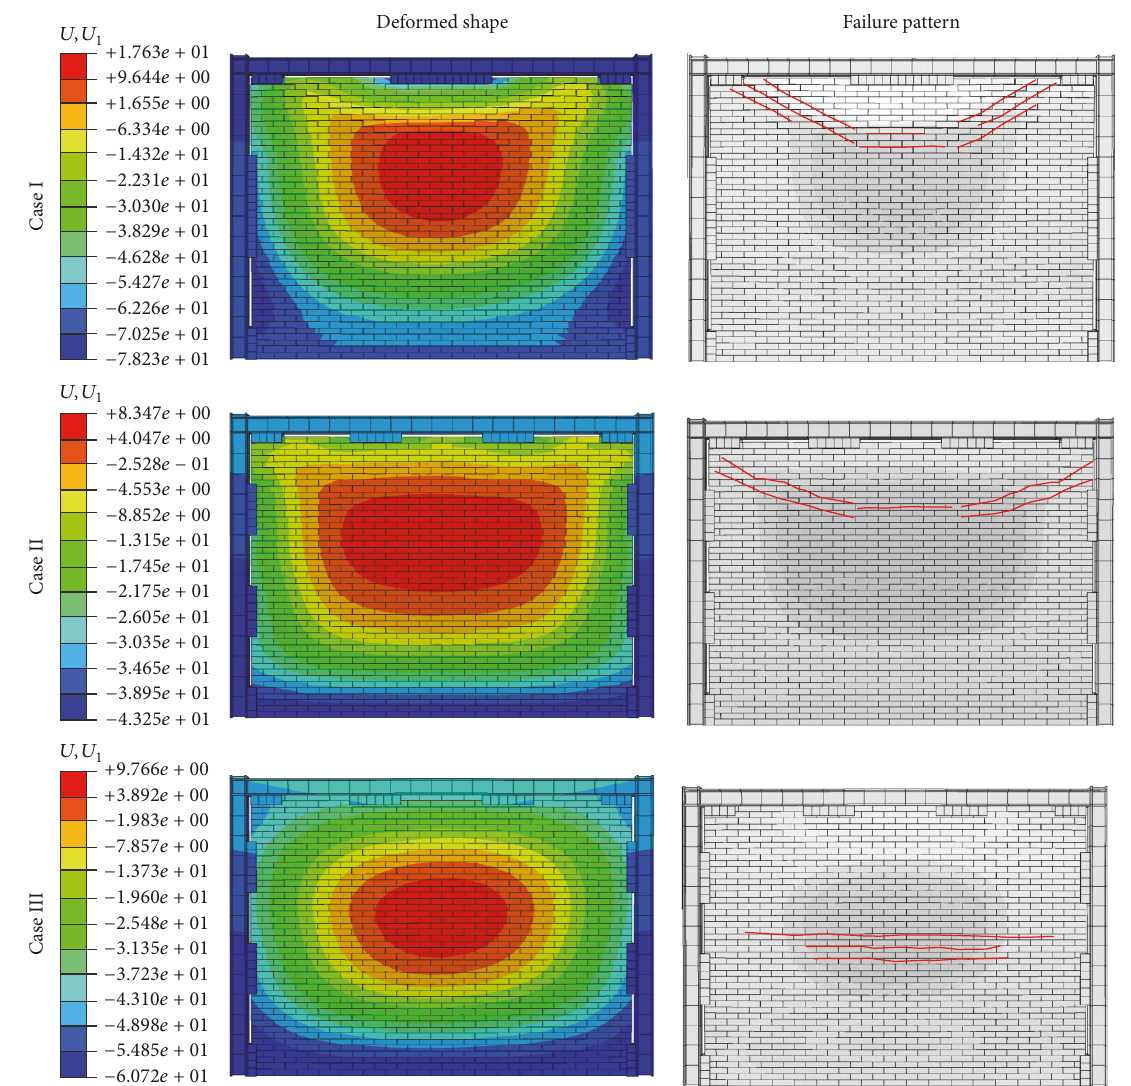
Figure 13: Deformed shape and the failure pattern of the infilled walls ( 𝐻/𝐿 = 0.6